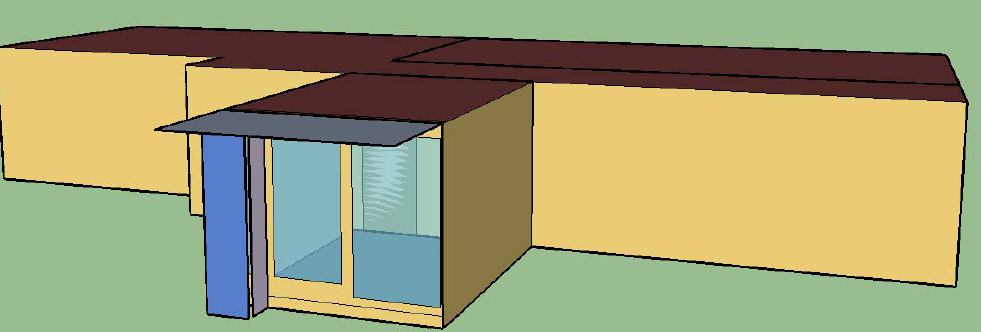
Figure 5. Model geometry of PCMroom in the Sonnenschiff and its surroundings in SketchUp. The front and upper shading objects represent the protection panel at the façade and the upper floor balcony, respectively. Window façade oriented towards east (92°) [Fraunhofer ISE].